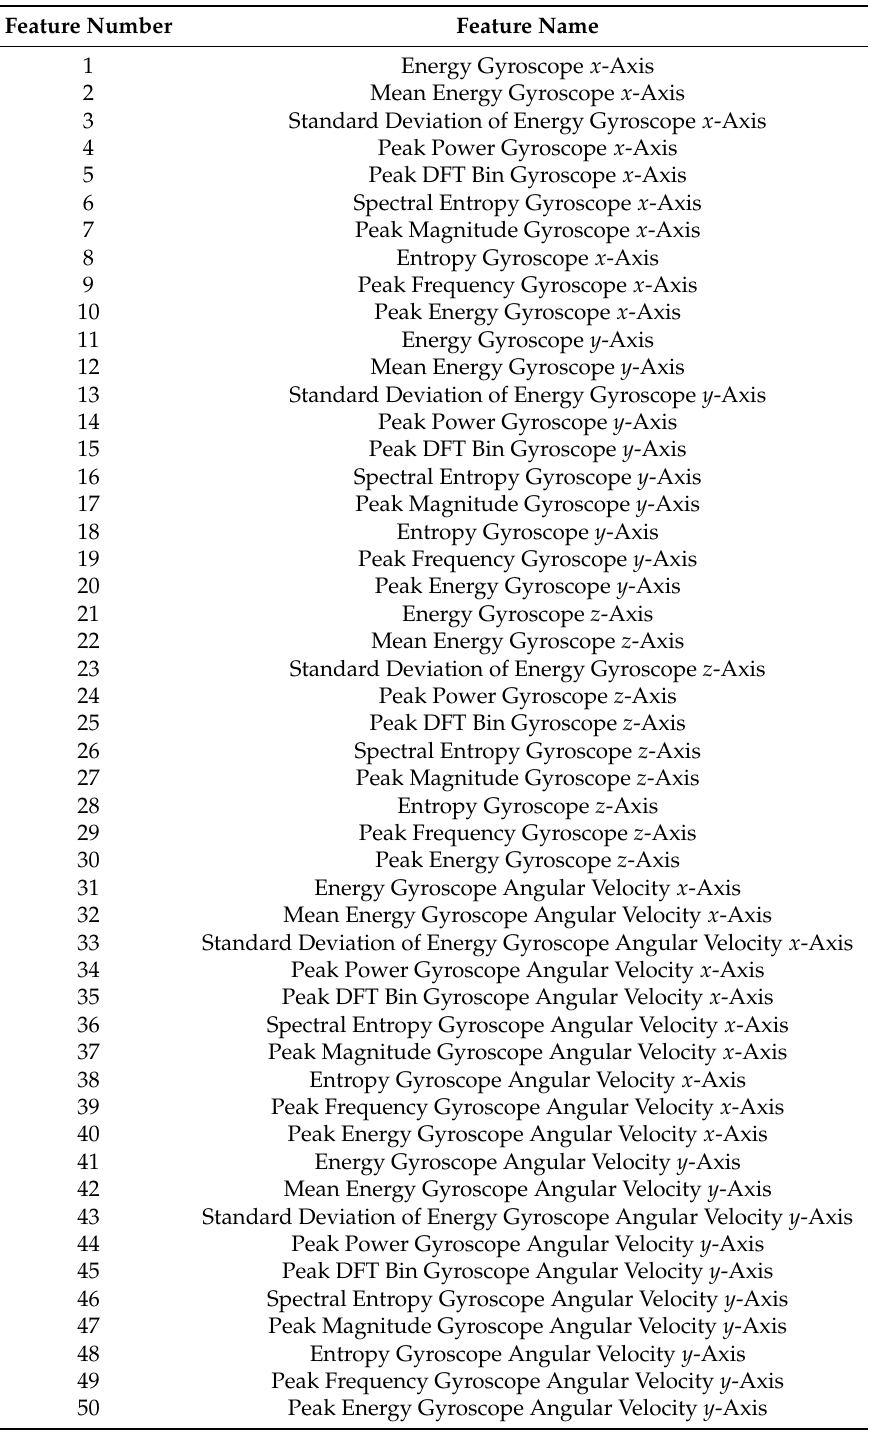
Table A1. Time/frequency-domain feature vector part